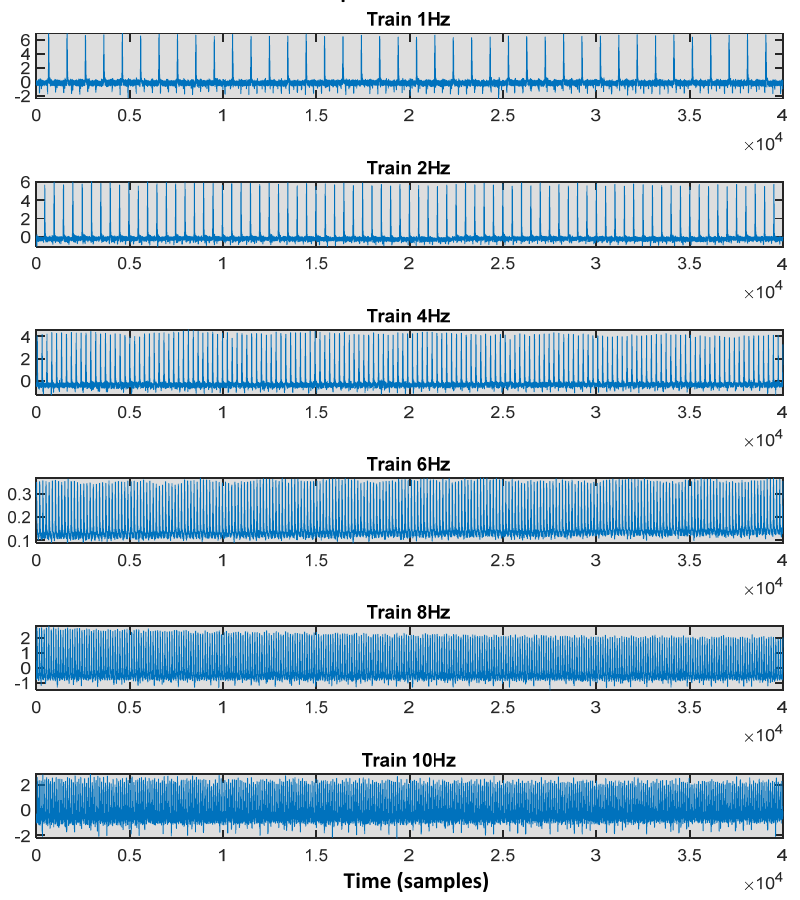
Figure 11. Normal experimental signals with different stimulation frequencies (1 to 10 Hz). These signals were used for training the anomaly detector that was applied to experimental signals.